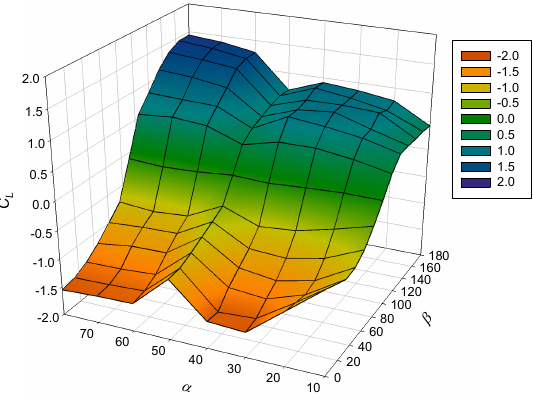
Figure 12. Uplift coefficient.